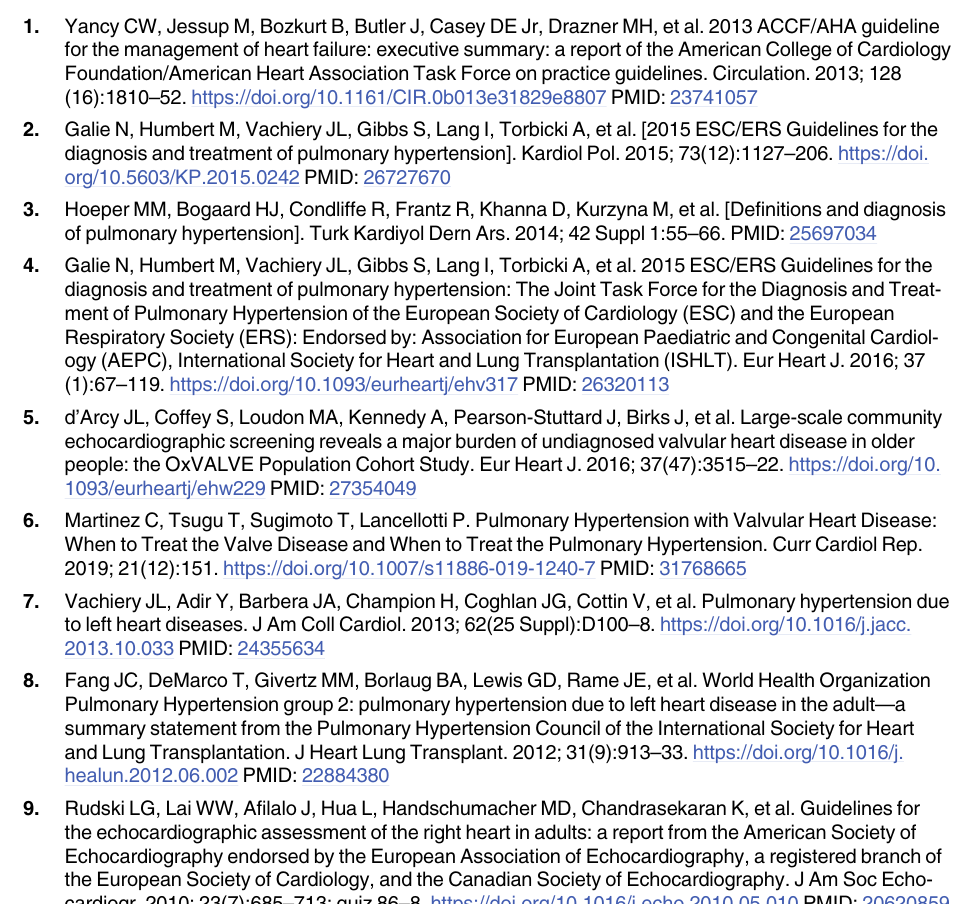
S1 Table. Single